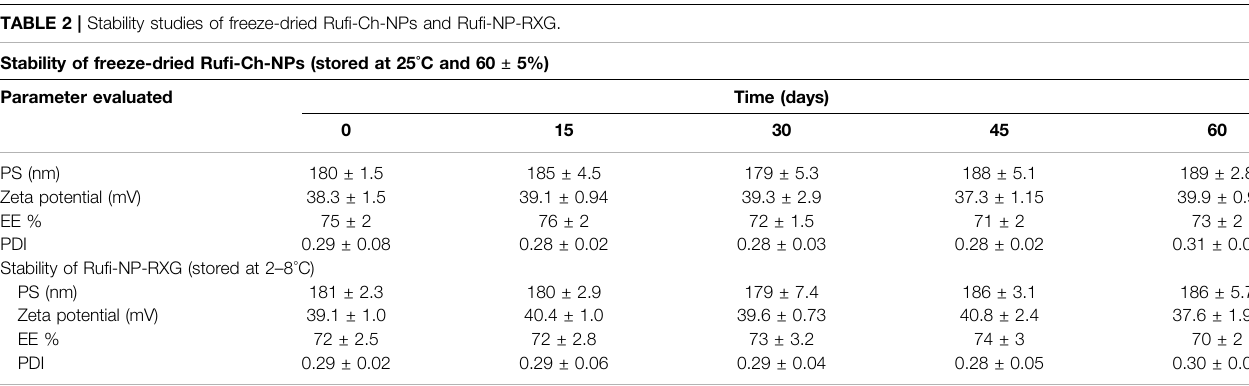
Data are represented as mean ± SD of n (cid:2) 3 replicates of each formulation stored at their respective storage